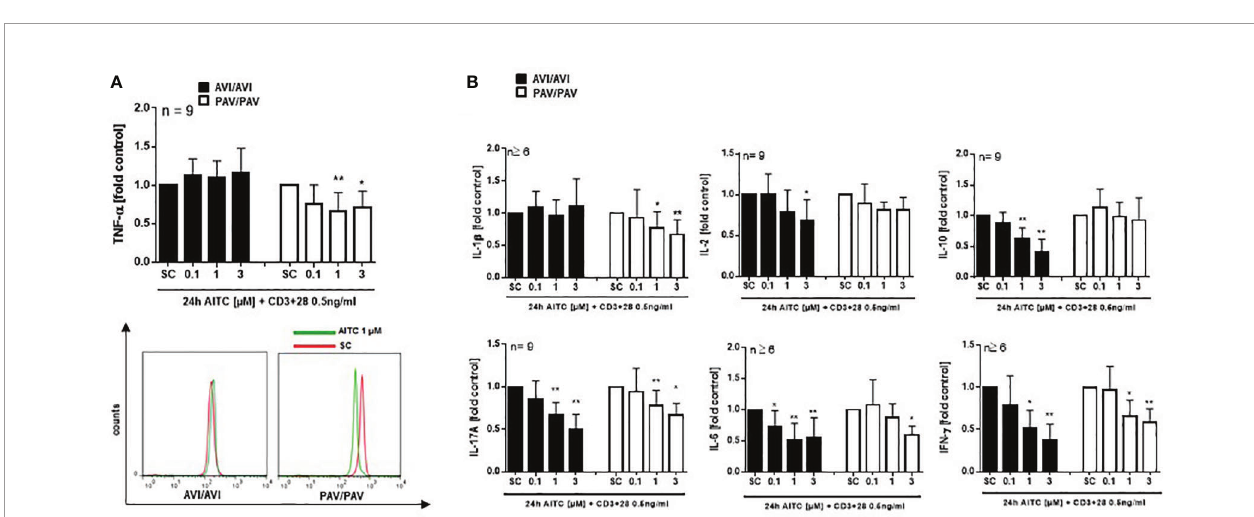
FIGURE 6 | In bacterial LPS stimulated PBMC, AITC triggers MAPK activation as well as TNF- a release in dependence of the TAS2R38 genotype. PBMC were exposed to AITC or 0.01% DMSO (SC) together with 0.5 ng/mL CD3/CD28 MAbs for 24h (A , B) . Cytokine secretion was analyzed using the human MACSplex cytokine 12-kit or ELISA kits. Results are mean values + SD and given as fold of the solvent control. Signi fi cance of difference was determined compared to the respective SC as determined by one-way ANOVA, *p<0.05,